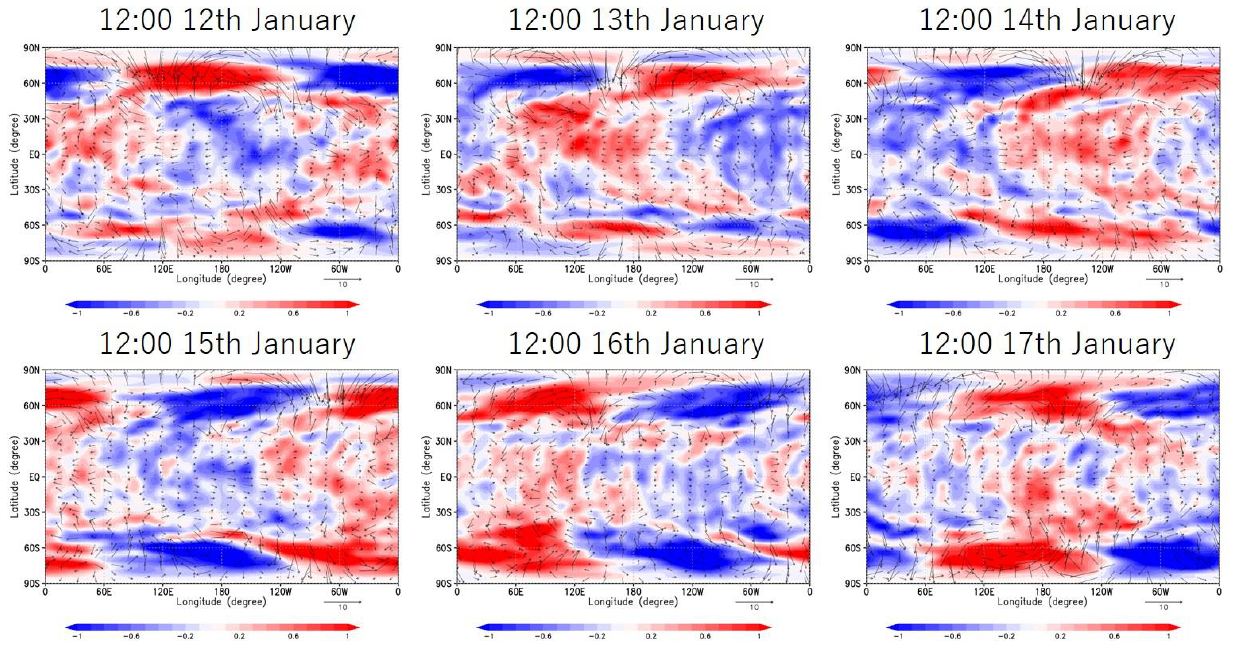
Figure 1. Longitude – latitude cross-sections of horizontal winds (m/s; vector) and temperature (K; Figure 1. Longitude–latitude cross-sections of horizontal winds (m/s; vector) and temperature color) deviations from their zonal averages at 70 km for the control case. (K; color) deviations from their zonal averages at 70 km for the control case.